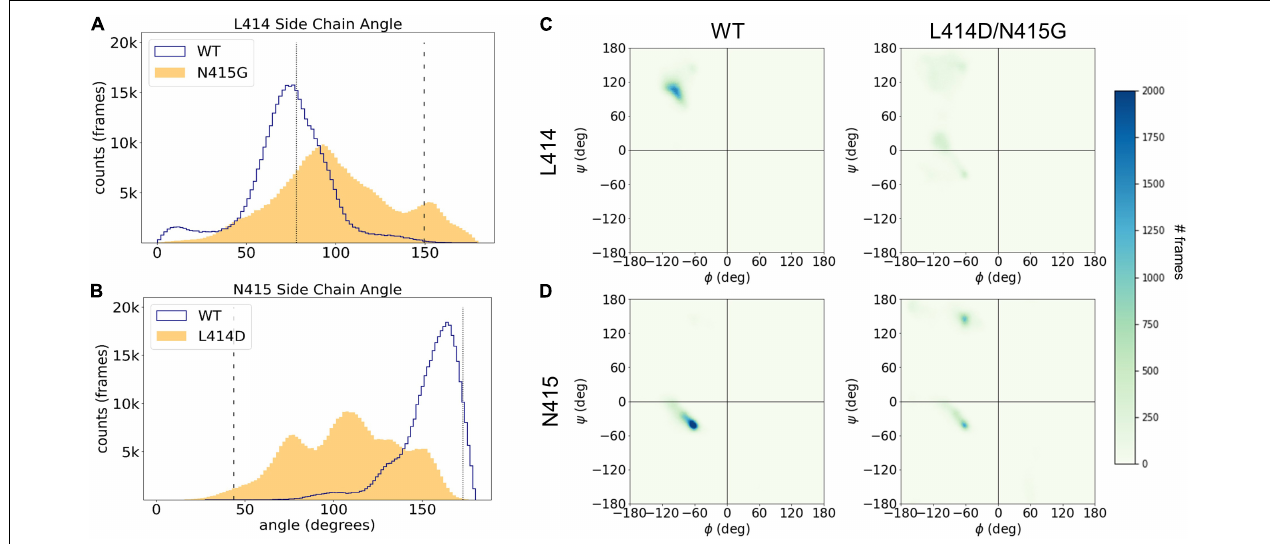
FIGURE 7 | Leu414 and Asn415 are more dynamic in mutant compared to WT simulations. (A) Histogram of side chain angle of Leu414 in all WT (blue trace) and N415G simulations (yellow area). The dotted line illustrates the side chain angle of L414 in the desensitized state structure while the dashed line illustrates the side chain angle in the resting state structure. (B) Same measurement as in panel (A) but comparing Asn415 sidechain angle in WT (blue trace) and L414D (yellow area) simulations. (C) Frequency of phi/psi pairs for Leu414 in WT simulations (left) or N415G simulations (right). (D) Frequency of phi/psi pairs Asn415 in WT simulations (left) or L414D simulations